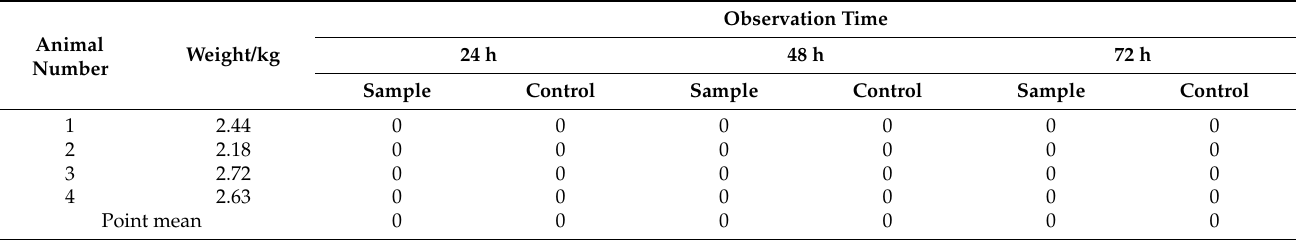
Table 4. Skin irritation